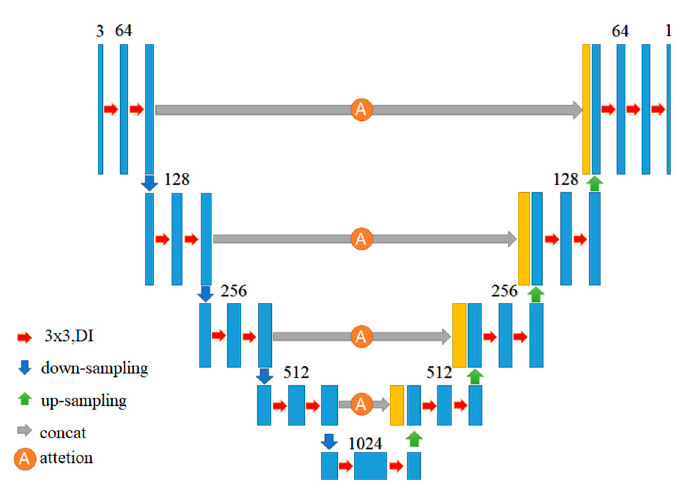
Figure 4. The architecture of the DIU-Net, where convolutional layers are replaced by DIs and the numbers indicate the number of channels.